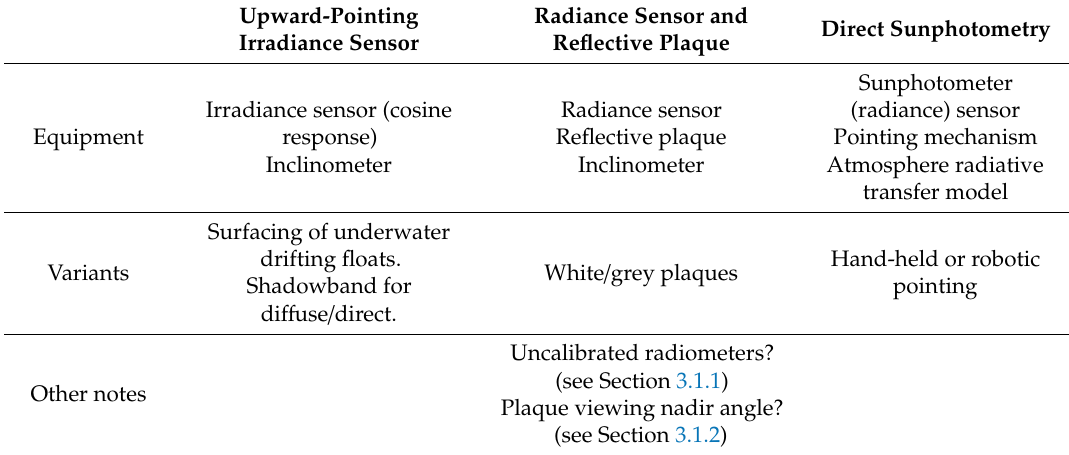
Table 1. Summary of the three measurement methods as regards equipment, method variants, and special